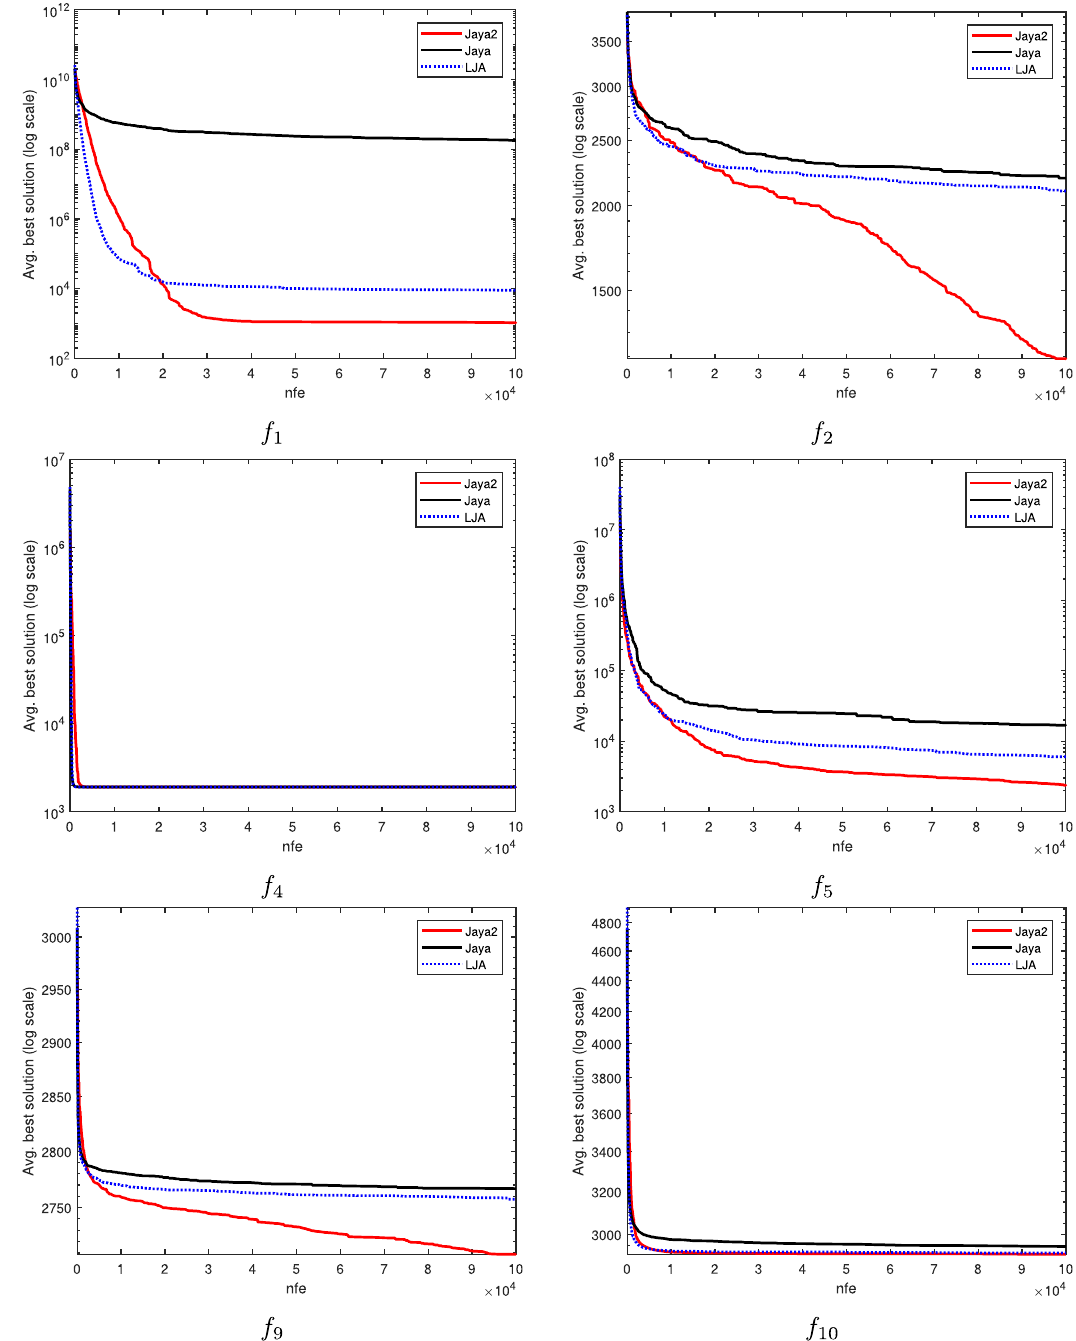
Figure 4: Best function value curves ( averaged across 30 runs ) of Jaya2, Jaya, and LJA for selected CEC 2020 benchmark functions ( = D 10 )